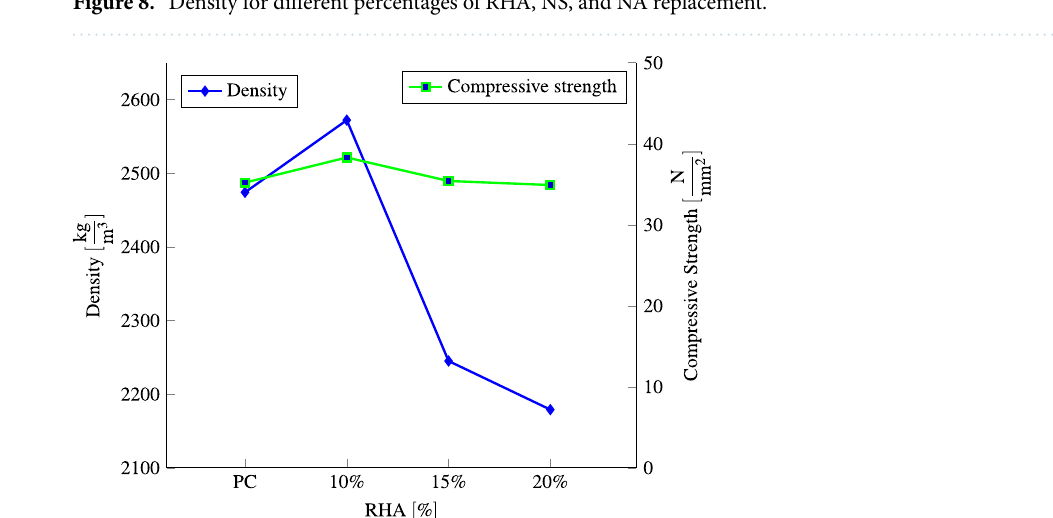
Figure 9. Relationship between compressive strength and density after 28 days for different percentages of